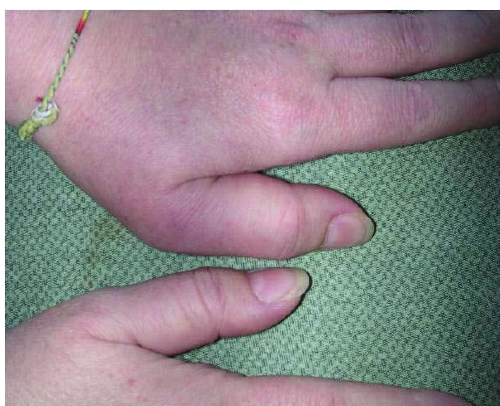
Figure 1: Dactyltis of the left thumb with the involvement of the metacarpophalangeal joint of the same finger.